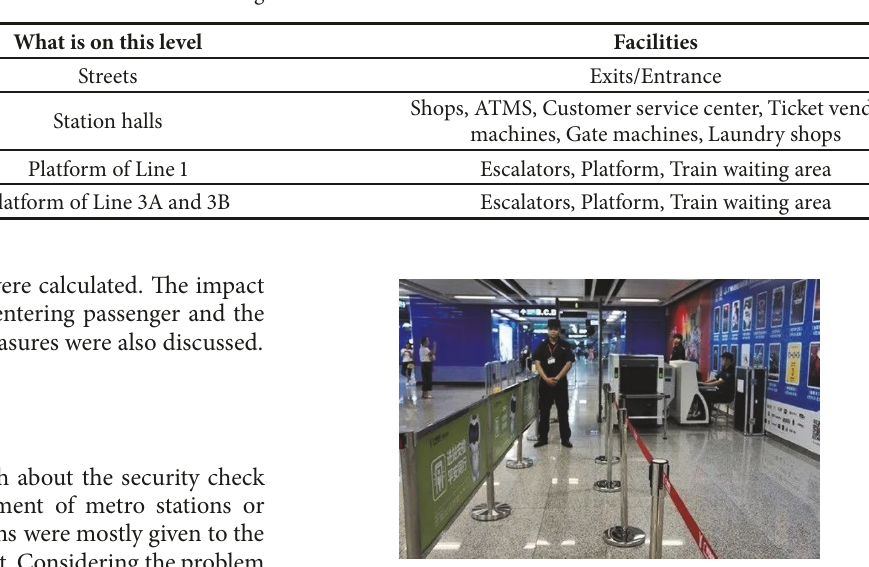
Table 1: Building structure of T Station.